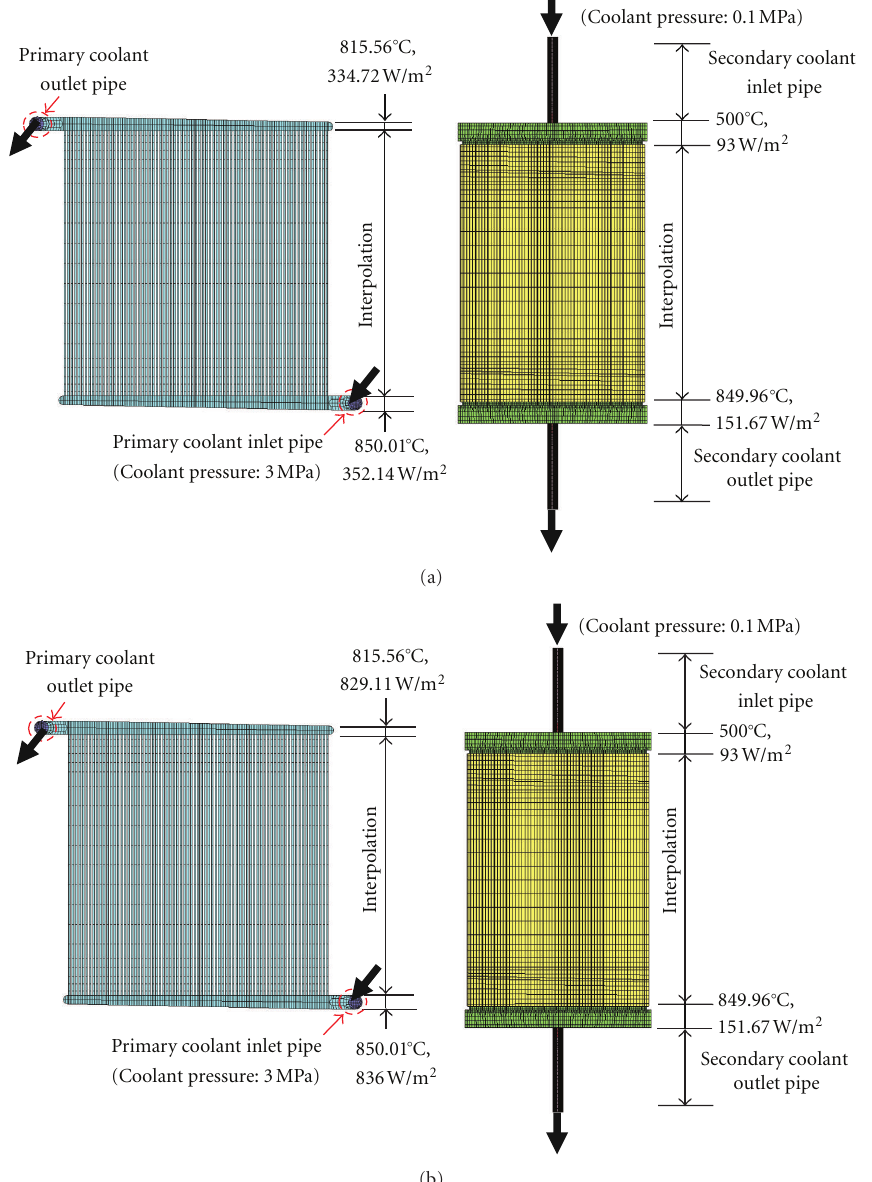
Figure 7: Boundary conditions of primary/secondary coolant for a thermal analysis: (a) 3 kW class PHE prototype and (b) 10kW class PHE